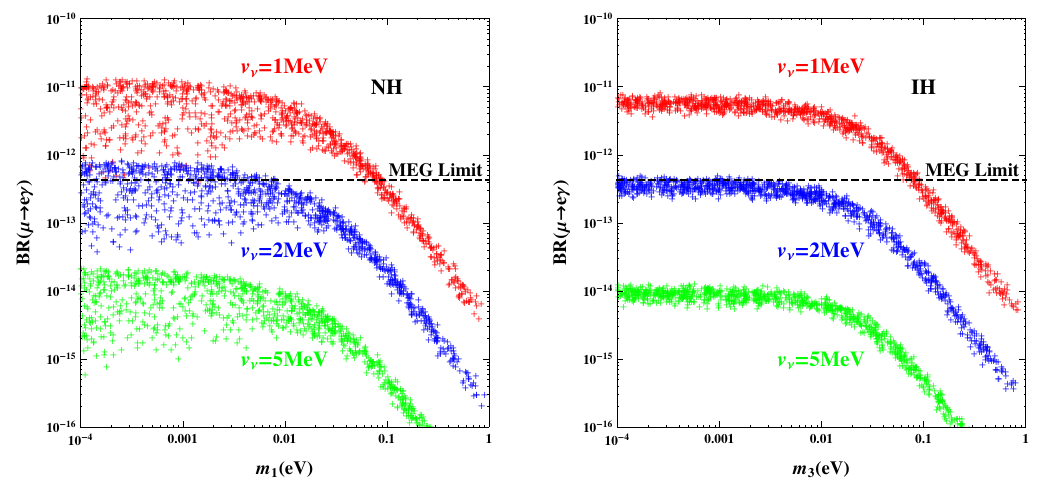
Figure 1 . BR( (cid:22) ! e(cid:13) ) as a function of the lightest neutrino mass for normal (left panel) and inverted (right) hierarchy at ( m